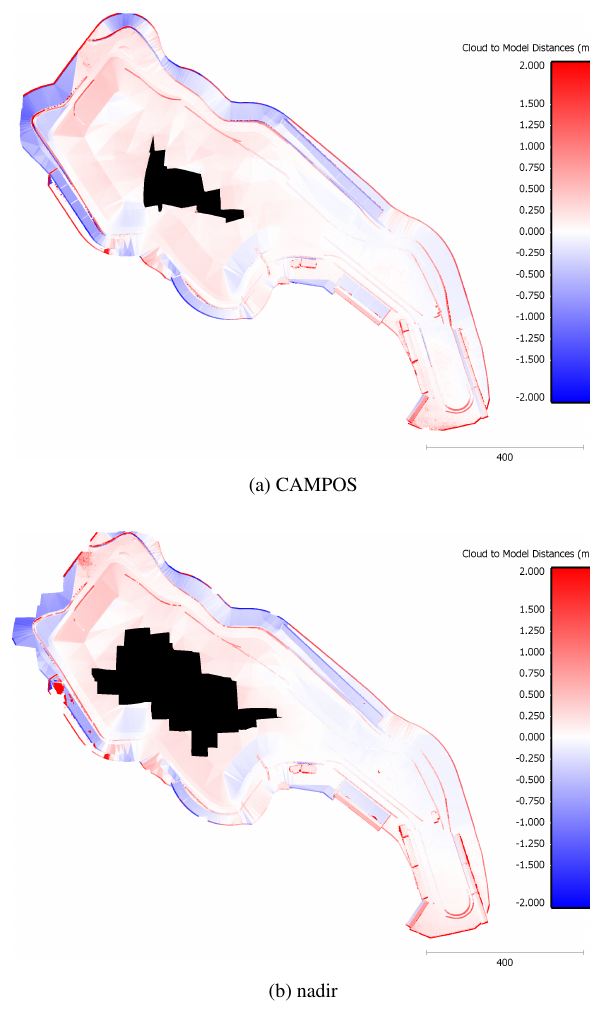
Figure 8. Distances between the original model and the dense point clouds generated from each survey method. The black areas show a hole in alignment that occurred due to low texture.